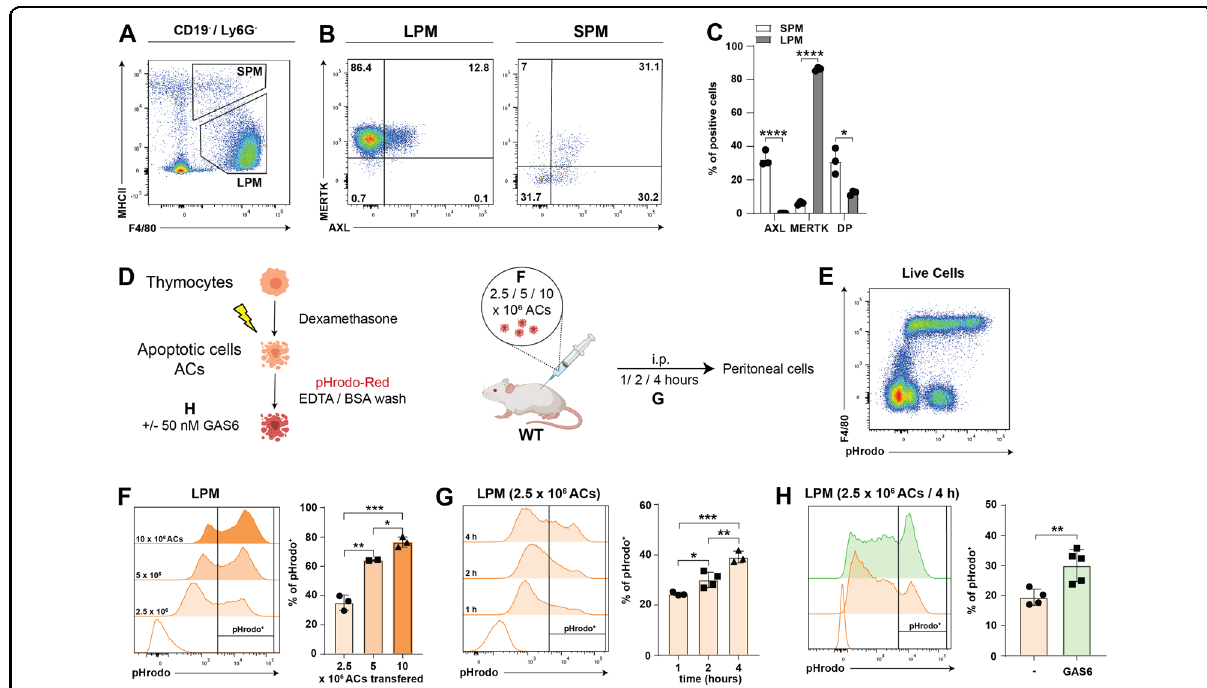
Fig. 3 GAS6 augments homeostatic efferocytosis in murine peritoneal macrophages. A Gating strategy to identify murine large (LPM) and small (SPM) peritoneal macrophages. Cells were gated as CD19 − , Ly6G − live cells. B Representative fl ow cytometric analysis for expression of AXL and MERTK on LPM and SPM. C Frequency of AXL or MERTK single and double positive LPM and SPM. Bar graphs show mean with SD and individual samples. D Experimental set-up to study efferocytosis in the murine peritoneum. Apoptotic cells (AC) were generated by treating murine thymocytes with dexamethasone. Afterwards, cells were labeled with pHrodo-Red and washed with EDTA/BSA and PBS. To set-up the model, initially different numbers of ACs were injected intraperitoneally. Peritoneal exudate cells (PECs) were analyzed at different time points by fl ow cytometry. Created with BioRender.com E Representative fl ow cytometric analysis of PECs for expression of F4/80 and pHrodo-Red signal. F Representative histograms for pHrodo-Red upon injection of different numbers of ACs and PECs isolated after 4 h (Gated on CD19 − , F4/80 + live cells). Statistical analysis of pHrodo + cells. Bar graphs show mean with SD and individual samples. G Representative histograms for pHrodo-Red upon injection of 2.5 × 10 6 ACs and PECs were isolated at indicated time points (Gated on CD19 − , Ly6G − , and F4/80 + live cells). Statistical analysis of pHrodo + cells. Bar graphs show mean with SD and individual samples. H Representative histograms for pHrodo-Red upon injection of 2.5 × 10 6 ACs with or without 50 nM GAS6. PECs were isolated at indicated time points (Gated on CD19 − , Ly6G − , and F4/80 + live cells). Bar graphs show mean with SD and individual samples. Data were representative of two individual experiments ( n = 3 –